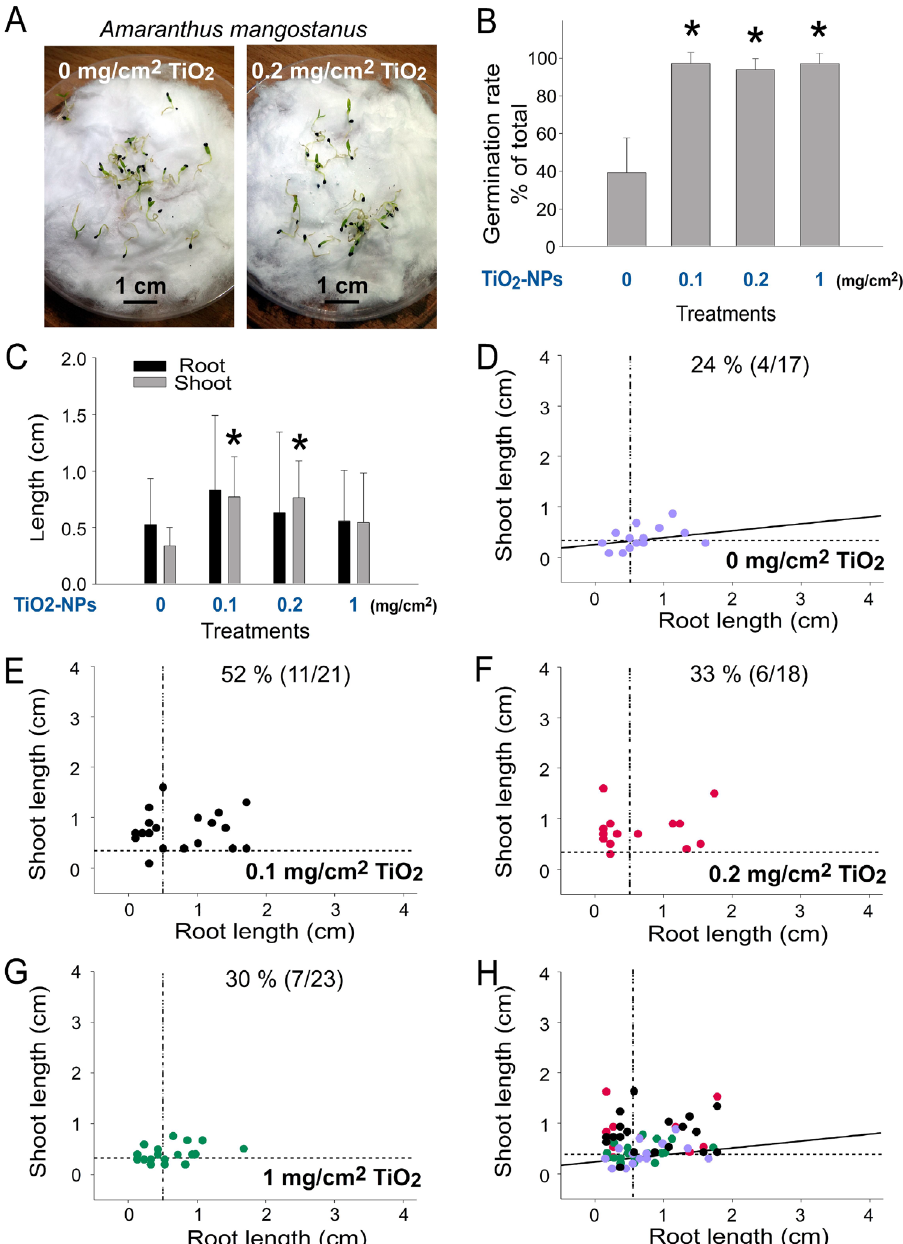
Figure 5. TiO 2 NP levels of sterilized cotton substrates positively affect the germination rate of Amaranthus mangostanus seeds. Analyses of image ( A ), seed germination rate ( B ) and root and shoot length ( C ) of 1-week- old Amaranthus mangostanus seedlings. Root–shoot 2D graphs of the seedlings without ( D ) and with different doses of TiO 2 NP treatments ( E–G ), and an overlay ( H ) are shown. The vertical and horizontal dotted lines in ( D–H ) are the mean values of root length and shoot length of the untreated control groups ( D ), respectively. * P < 0.05 vs. 0 mg/cm 2 TiO 2 untreated groups. n = 3 (3 independent experiments; each experiment with 30 seeds) ( B ). n = 90 (3 independent experiments; each experiment with 30 seeds) ( C ). n = 30 (3 independent experiments; each experiment with 10 seeds) ( D–H ). Scale bars: 1 cm ( A